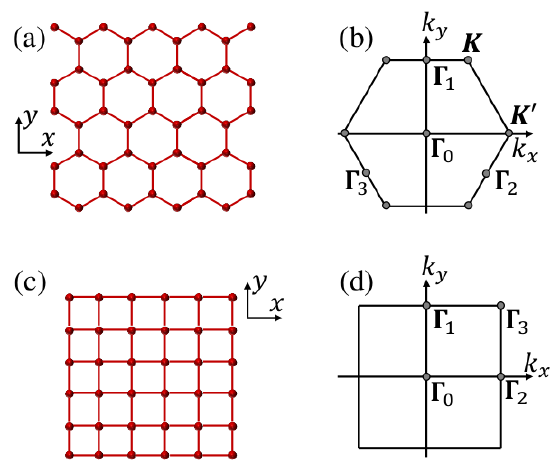
Figure 1: (Color online) (a) Direct and (b) reciprocal lattice for the honeycomb-based systems described by the KM Hamiltonian. (c) Direct and (d) reciprocal lattice for the BHZ Hamiltonian discretized on a square lattice. Here, the time-reversal invariant momenta Γ of the hexagonal and square lattices are also 0 − 3